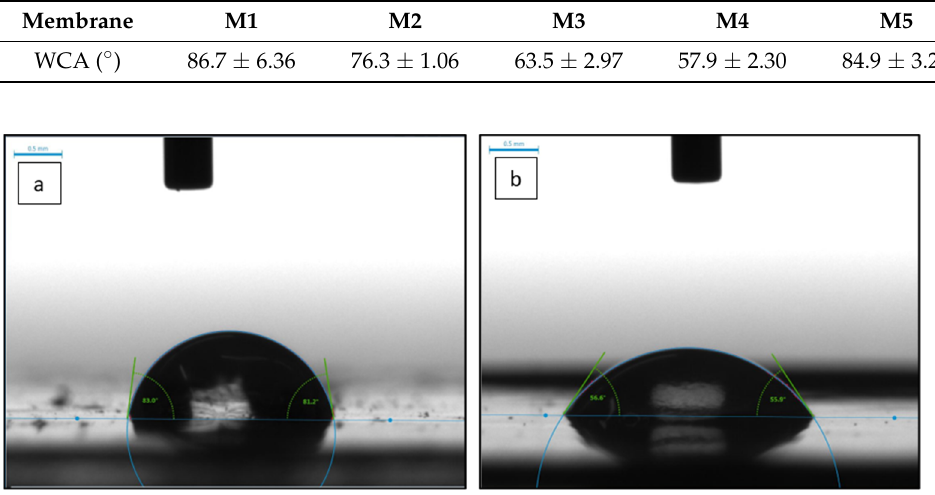
Figure 11. DI water drops images for: ( a ) PSF membrane (M1) and ( b ) PSF membrane with 0.3 wt.% CNF (M4).